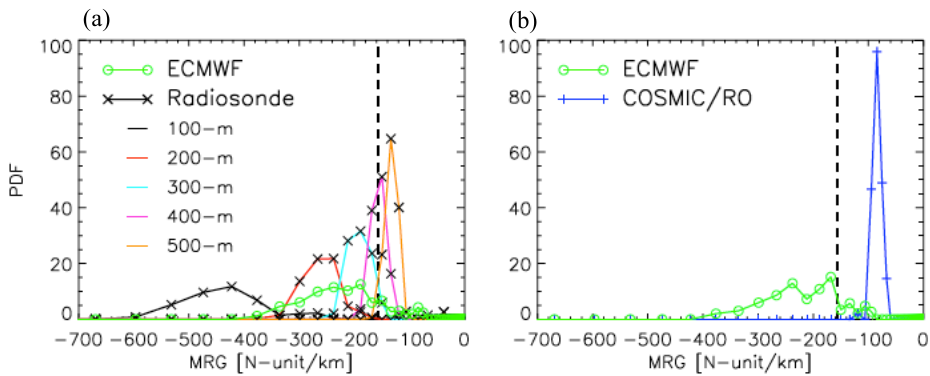
Fig. 5. (a) PDF of MRG for the radiosondes (190 profiles, with different vertical smoothing) and the near-coincident ECMWF analysis over the region (15–25 ◦ S, 70–86 ◦ W); (b) PDF of the MRG for COSMIC RO soundings (70 profiles) and the near-coincident ECMWF analysis over the region (20–25 ◦ S, 70–86 ◦ W) from 25 October to 1 December 2008. The vertical black dashed lines denote the critical refraction gradient ( − 157N-unitkm − 1 ). The normalized PDF is multiplied by 20 for better illustration.